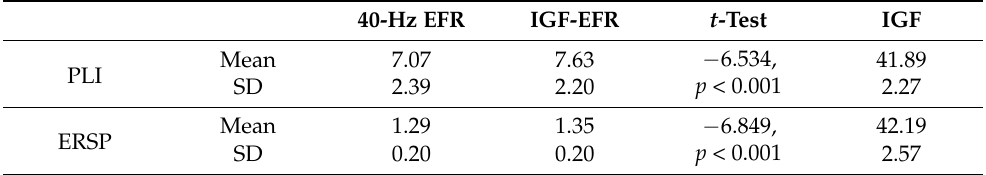
Figure 3. Individual phase-locking index ( PLI ) and event-related spectral perturbation ( ERSP ) curves with individual gamma frequency distributions. Table 2. Means and standard deviations of PLIs and ERSPs at 40 Hz and at IGFs.